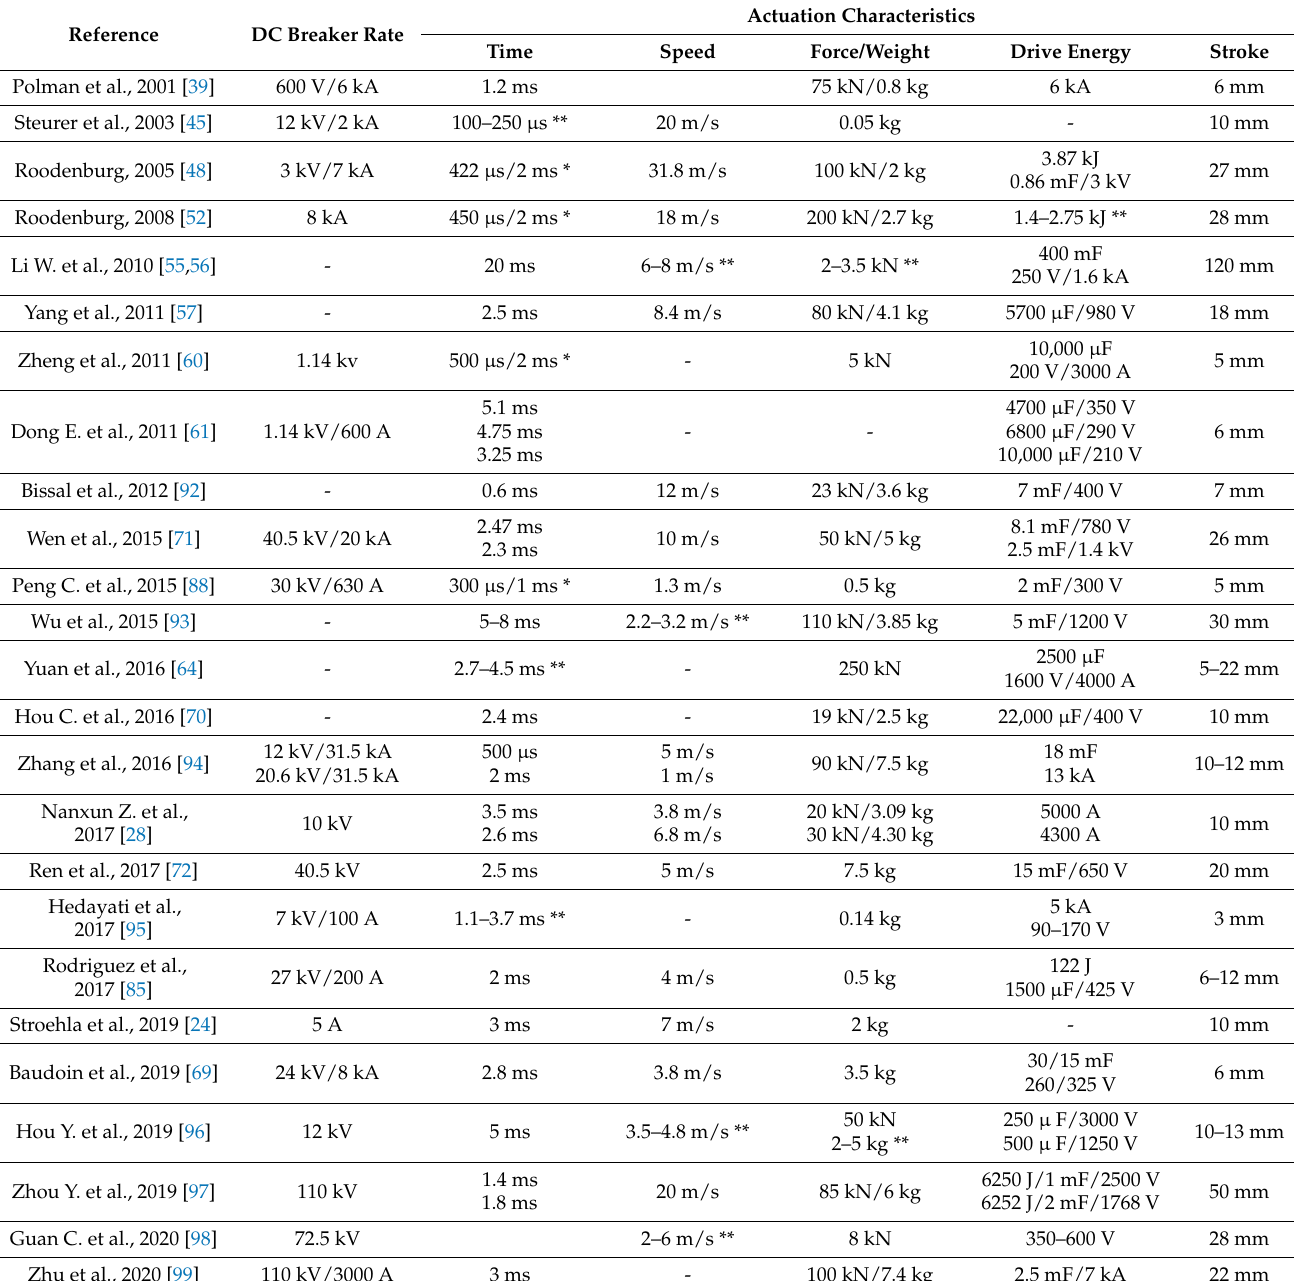
Table 1. Experimental performances of TCAs in the